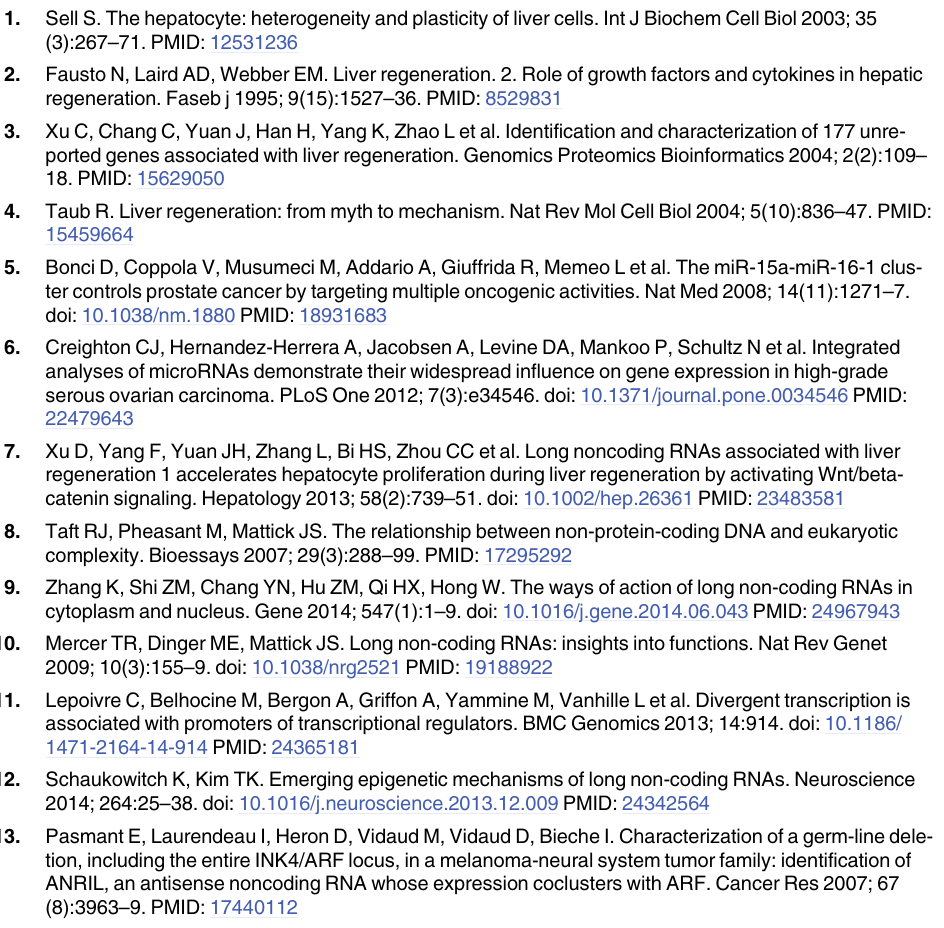
S1 Table. Candidate-lncRNA. S2 Table. LncRNAs and target genes primers used in RT-PCR. S3 Table. Expression profile of lncRNAs during rat